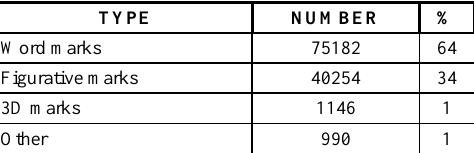
Table 4: Applications Bon Type of Trade Mark (Units, %)